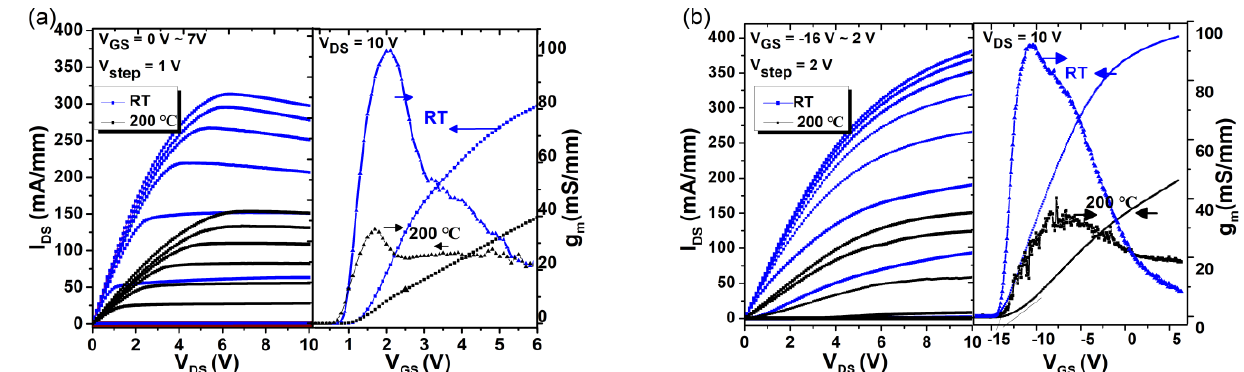
Figure 3. Direct current (DC) output and transfer characteristics for ( a ) E-mode GaN HEMT with L G /L GS /L GD = 1.8/1/5-μm and ( b ) D-mode GaN HEMT with L G /L GS /L GD = 1.5/1/5-μm.